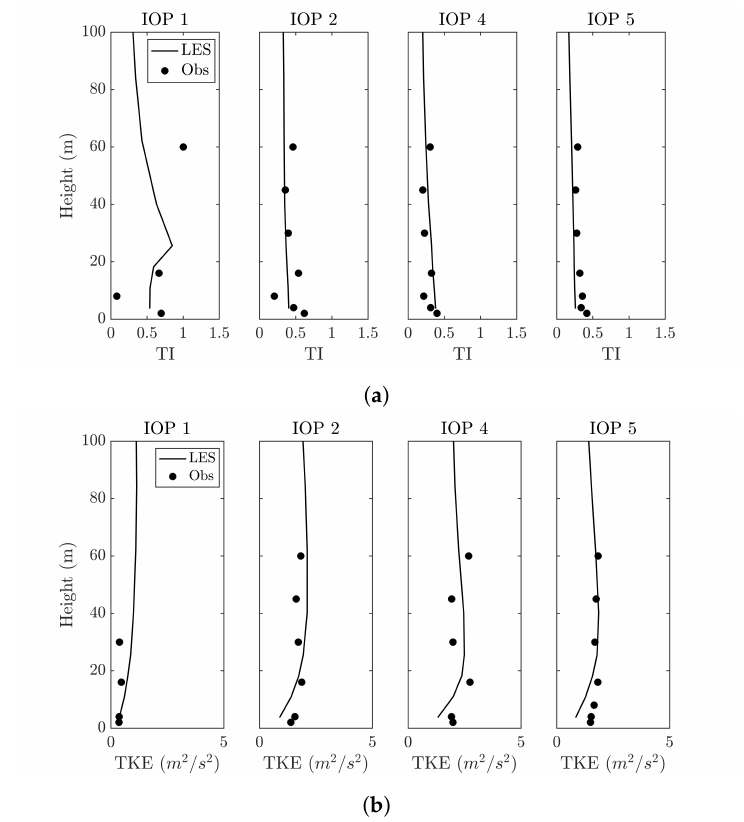
Figure 10. The 2.5 h time averaged: ( a ) turbulence intensity profile up to 100 m; and ( b ) TKE profile up to 100 m during IOPs 1, 2, 4 and 5. Black dots represent the observed values from 3D sonic-anemometers positioned on the GRI tower during